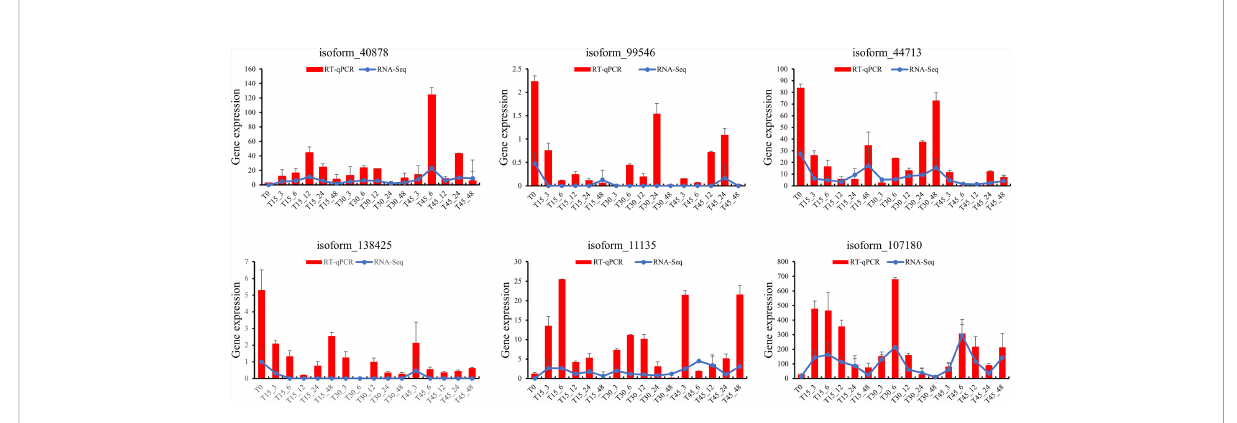
FIGURE 8 Comparative analysis of the quantitative polymerase chain reaction (qPCR) and transcriptome data for six